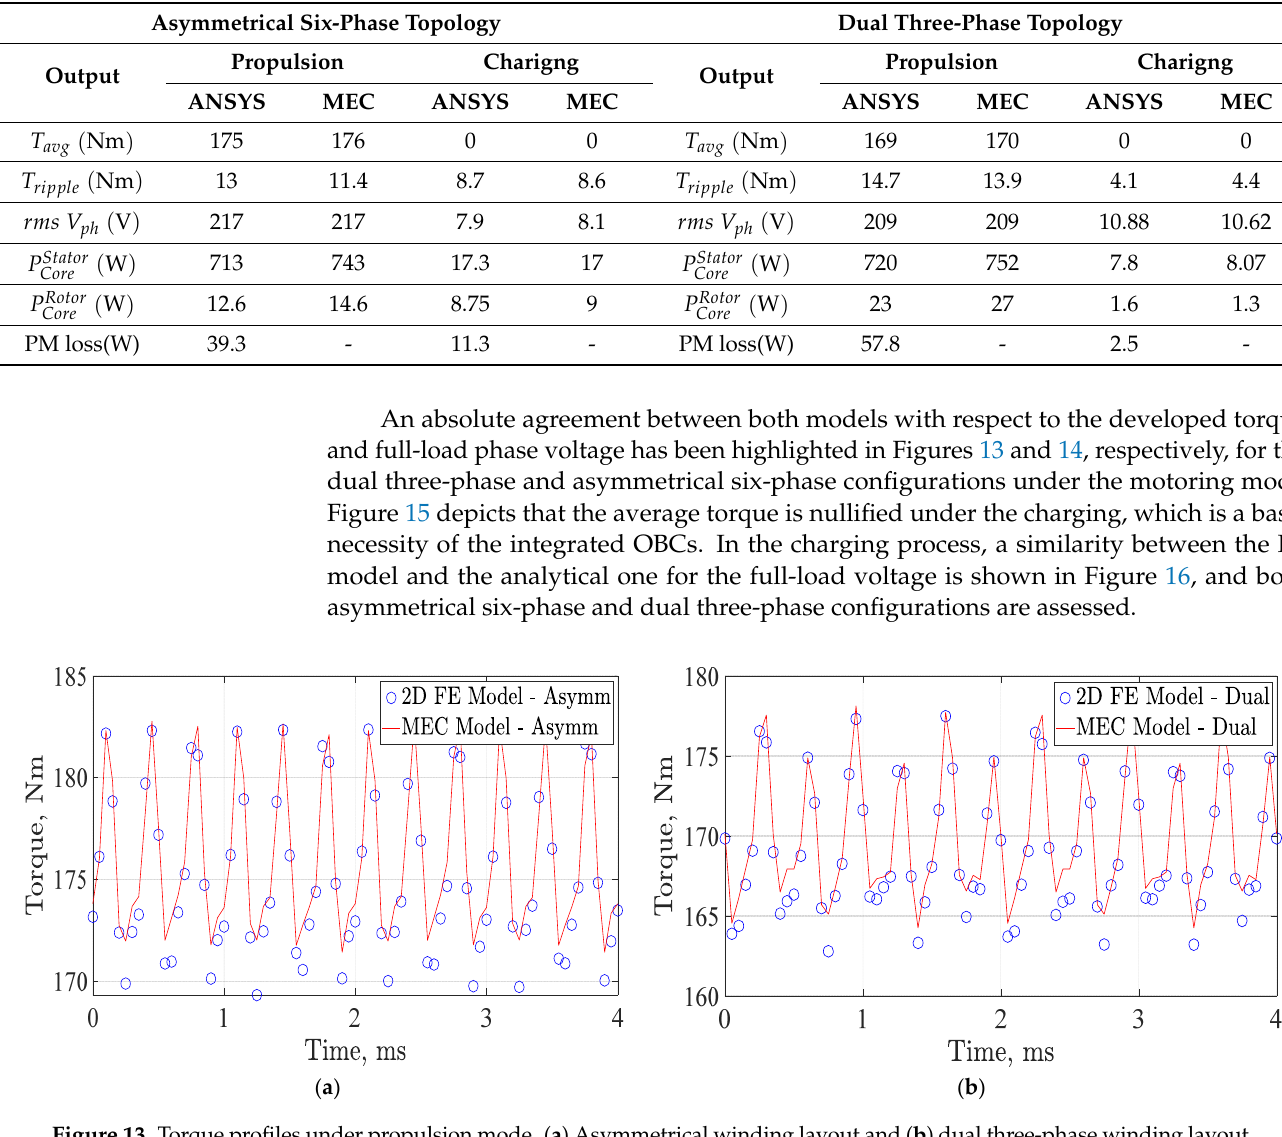
Figure 13. Torque profiles under propulsion mode. ( a ) Asymmetrical winding layout and ( b ) dual three-phase winding layout.